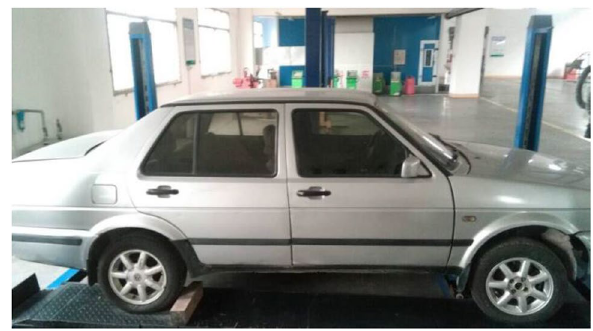
Fig. 1 Noise test vehicle